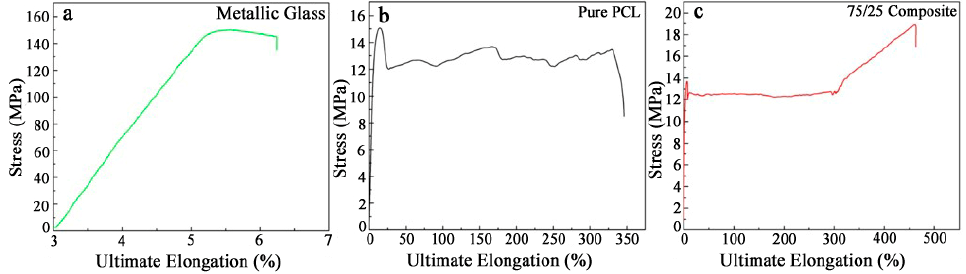
Figure 1. Tensile engineering stress-strain curves for ( a ) Mg 66 Zn 30 Ca 4 glassy ribbon, ( b ) pure polycaprolactone, and ( c ) Mg 66 Zn 30 Ca 4 / PCL 75 / 25 composite. Table 1. Mechanical properties of the obtained samples.